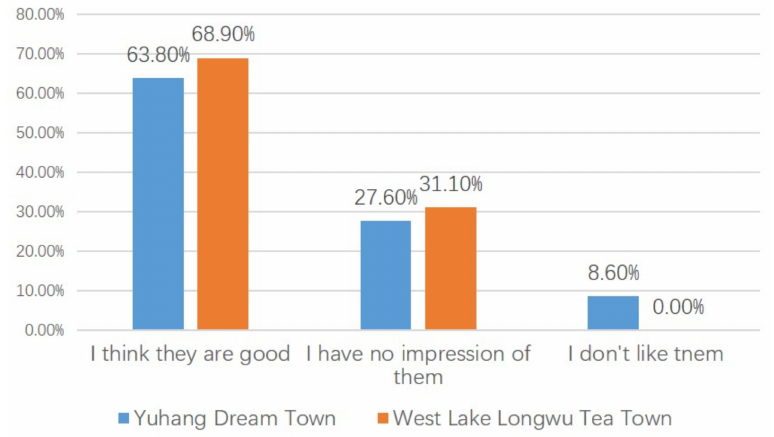
Figure 29. Respondents’ impression of migrant workers due to the local CT practice (source: authors).